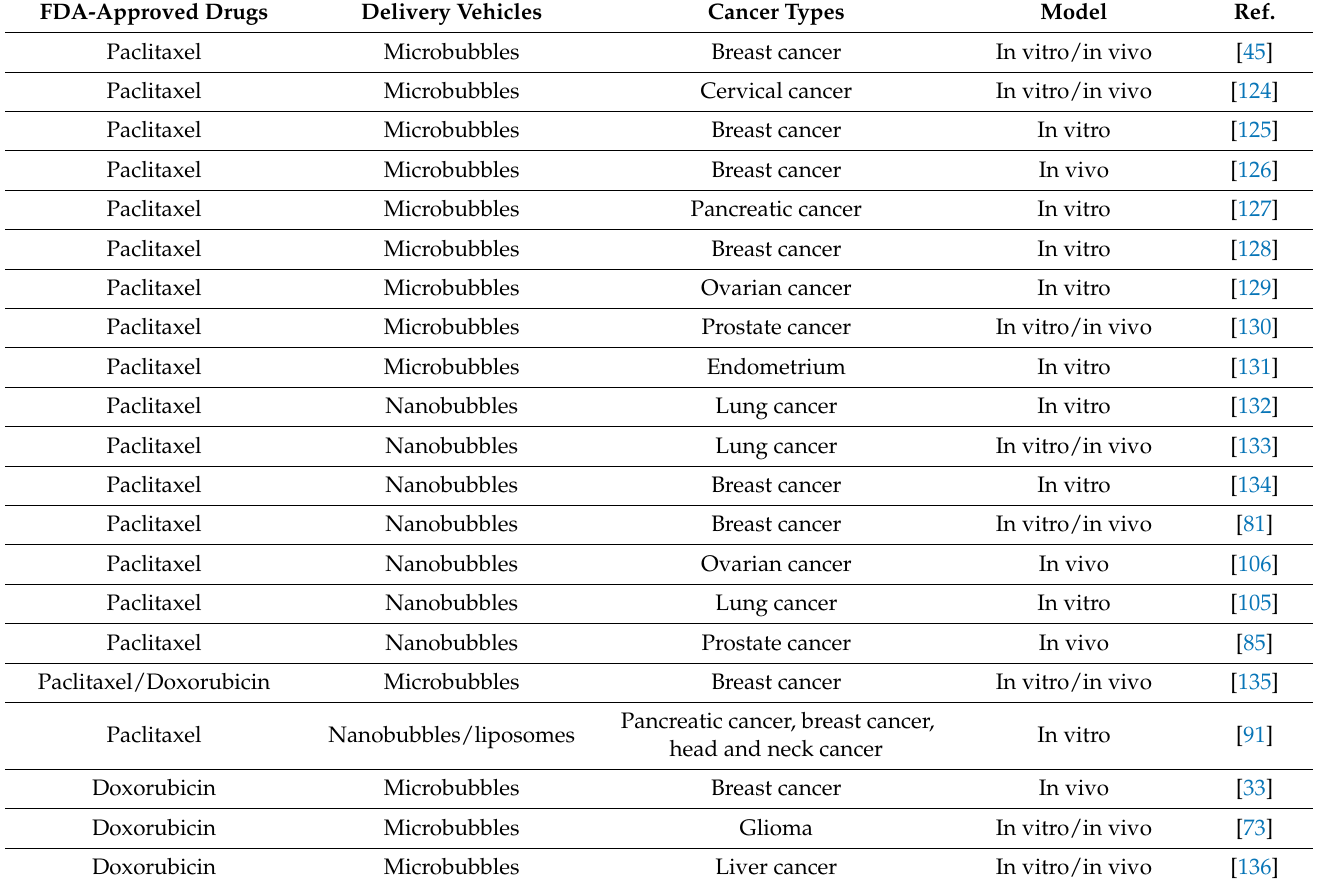
Table 2. Ultrasonic therapies for cancer treatment with three different FDA-approved drug deliv- ery